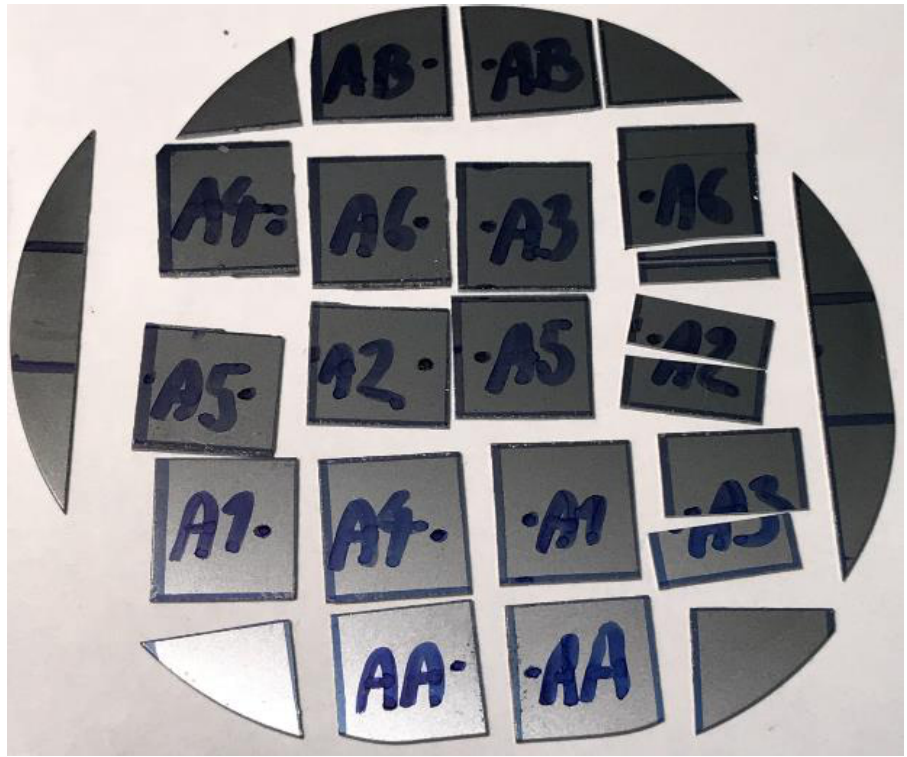
Figure 1. As-prepared test samples of the GaAs as per Table 1 for the irradiation experiment.